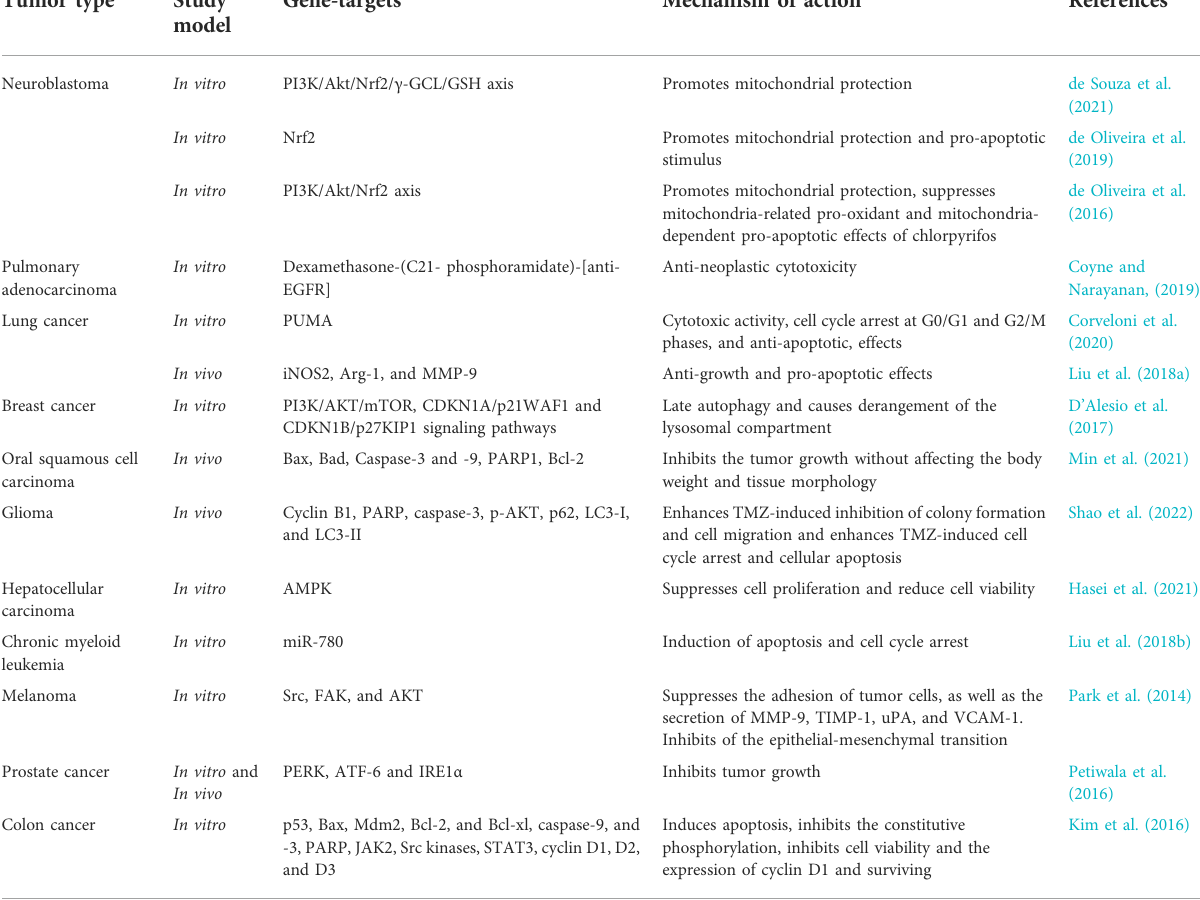
TABLE 3 Results of some preclinical experiments on the study of the therapeutic effect of carnosic acid in